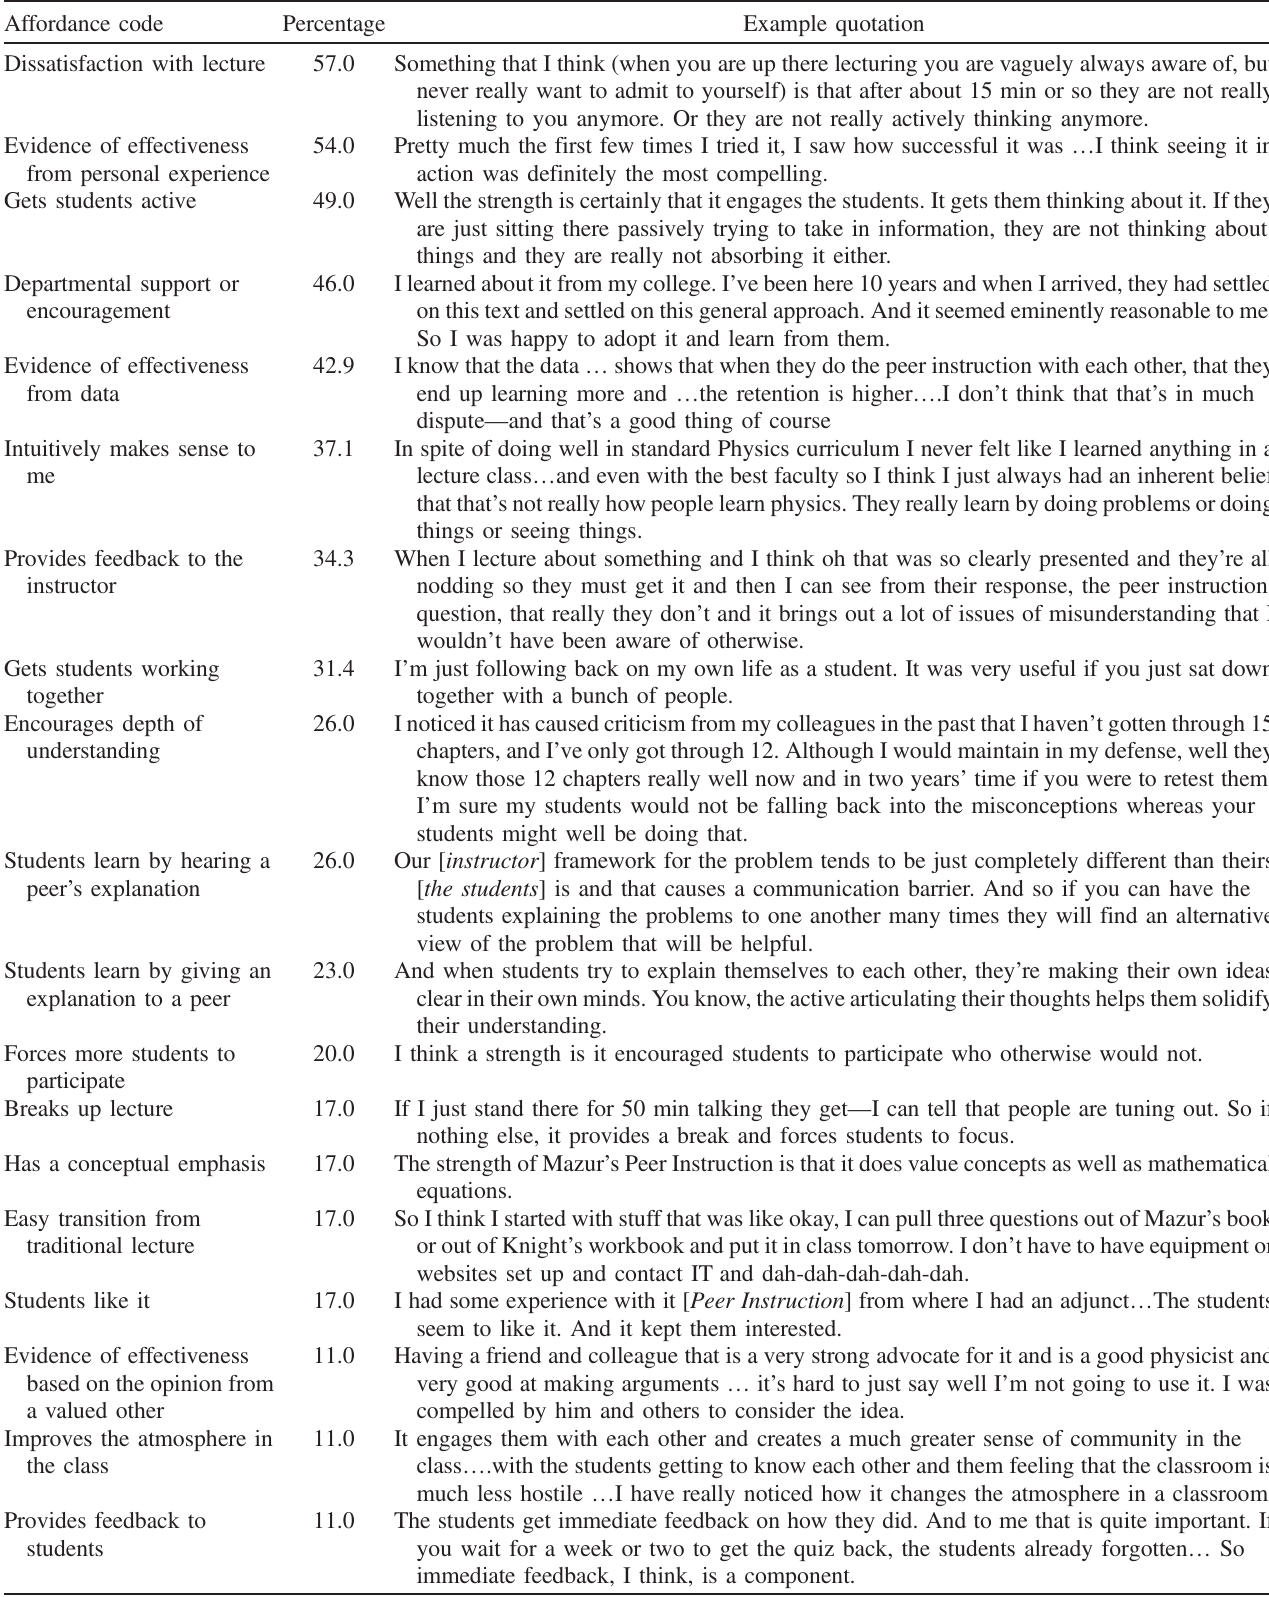
TABLE I. Affordances of Peer Instruction. Rank-ordered list of reasons given for aligning instructional practices with PI (or PI